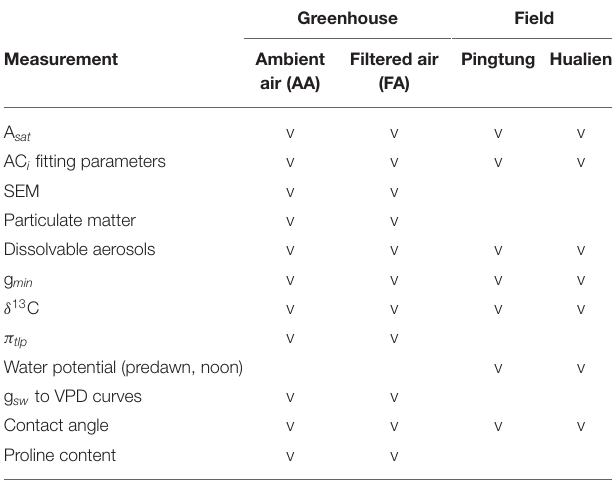
TABLE 1 | An overview of Cinnamomum camphora measurements in the greenhouses and the fields.